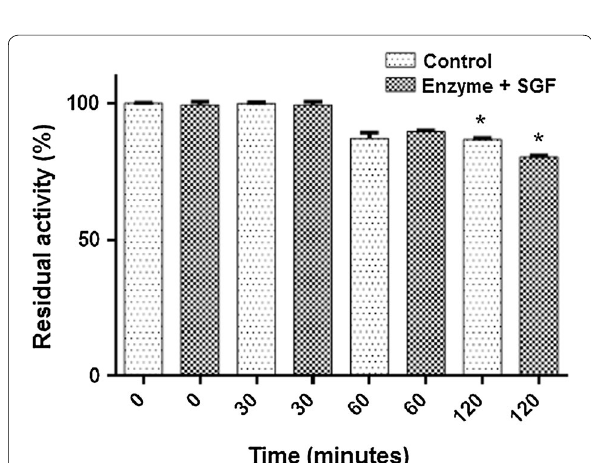
Fig. 6 The effect of in vitro simulated fasted gastric (SGF) conditions on partially purified β‑galactosidase. Control: enzyme incubated with buffer pH 2.0. Enzyme SGF (NaCl 2%, bovine pepsin 0.32% and HCl + 7%). *Indicates statistical difference in the ANOVA Tukey test with significance level (p < 0.05) between control and enzyme +